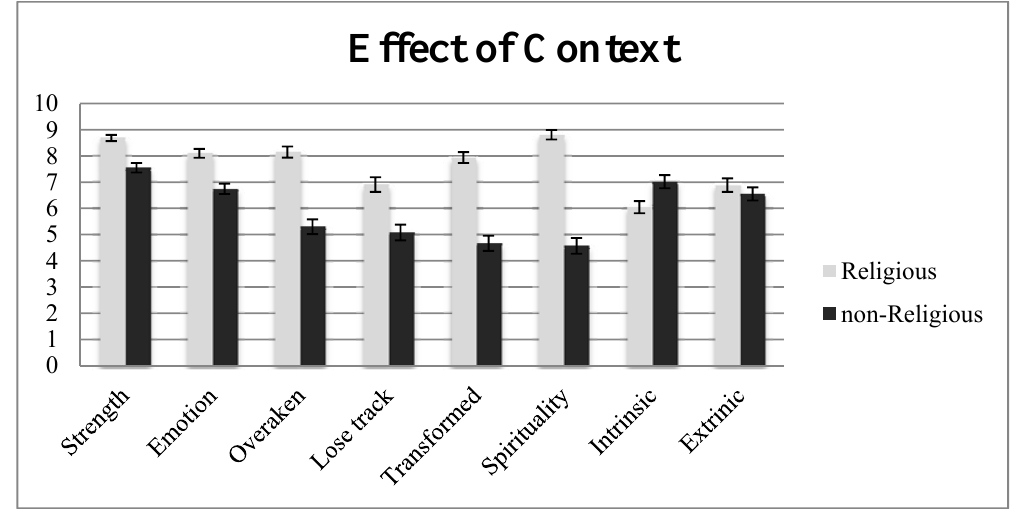
Figure 1. Mean element ratings comparing religious and non-religious contexts.